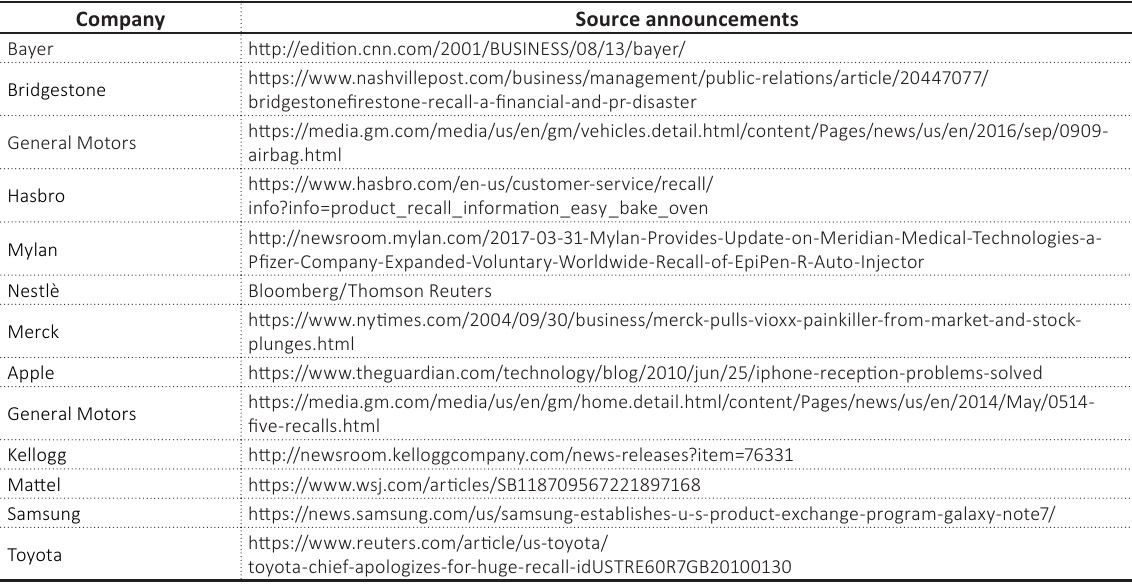
Table A6. Product recall. Shock event announcement